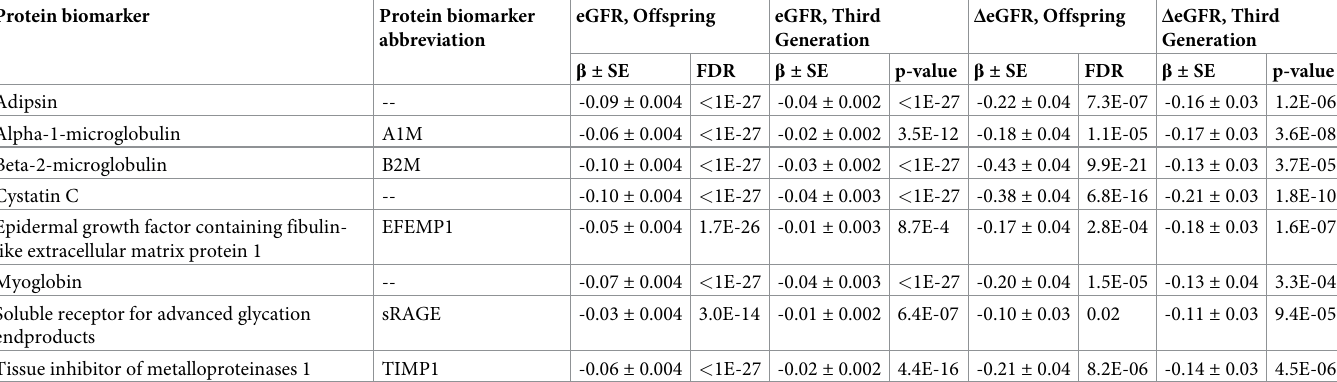
Table 2. Biomarkers associated with eGFR and Δ eGFR in the FHS Offspring and Third Generation cohorts. Protein biomarker Protein biomarker